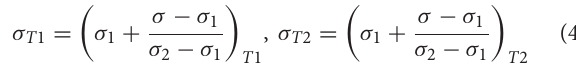
true strain vs. true stress curves. Uniaxial stress-strain curves for different strain rates at temperature T 1 are schematically